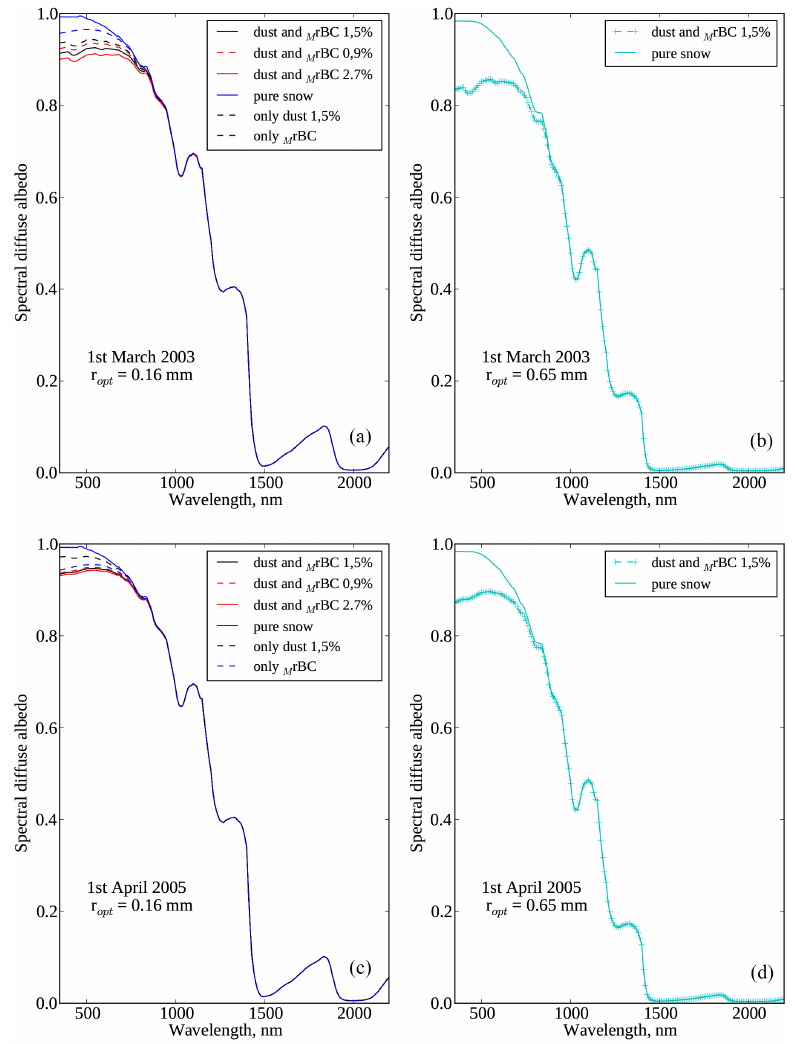
Figure 5. Simulated spectral albedo 1 March 2003 for different grain sizes, for different hematite content (0.9, 1.5 and 2.7%), for pure snow and for different concentration and characteristics of impurities (a, b) , and for the 1 April 2005 (c, d)